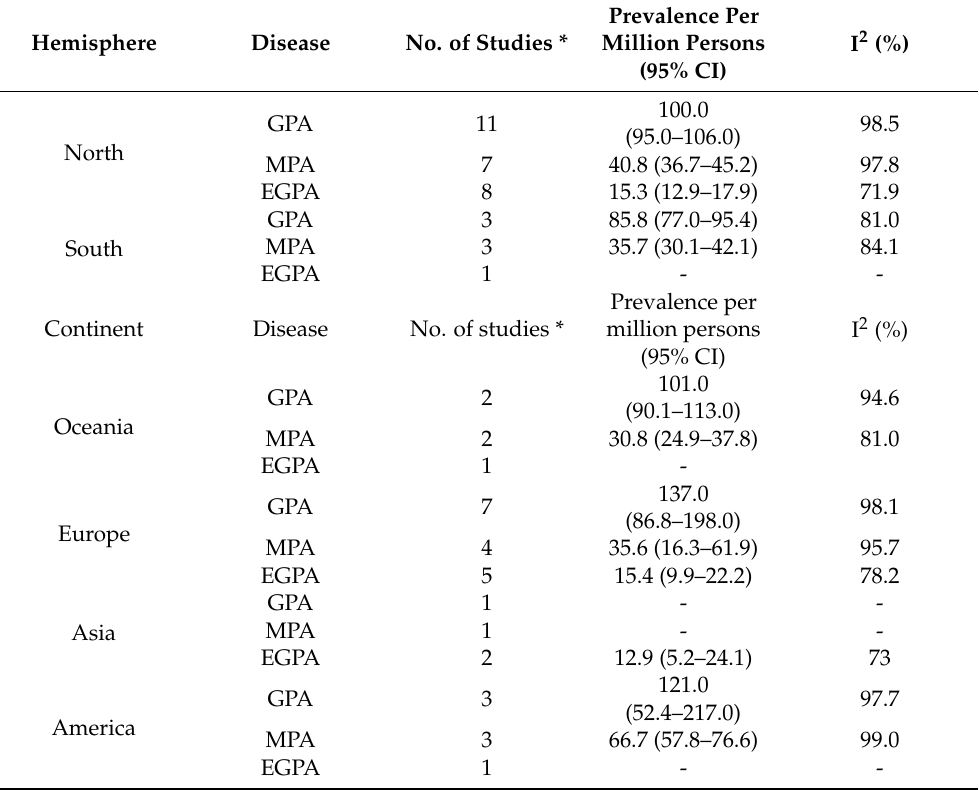
Table 8. Pooled prevalence of ANCA-associated vasculitis by geographic region (number of studies included, 95% CI, and I 2